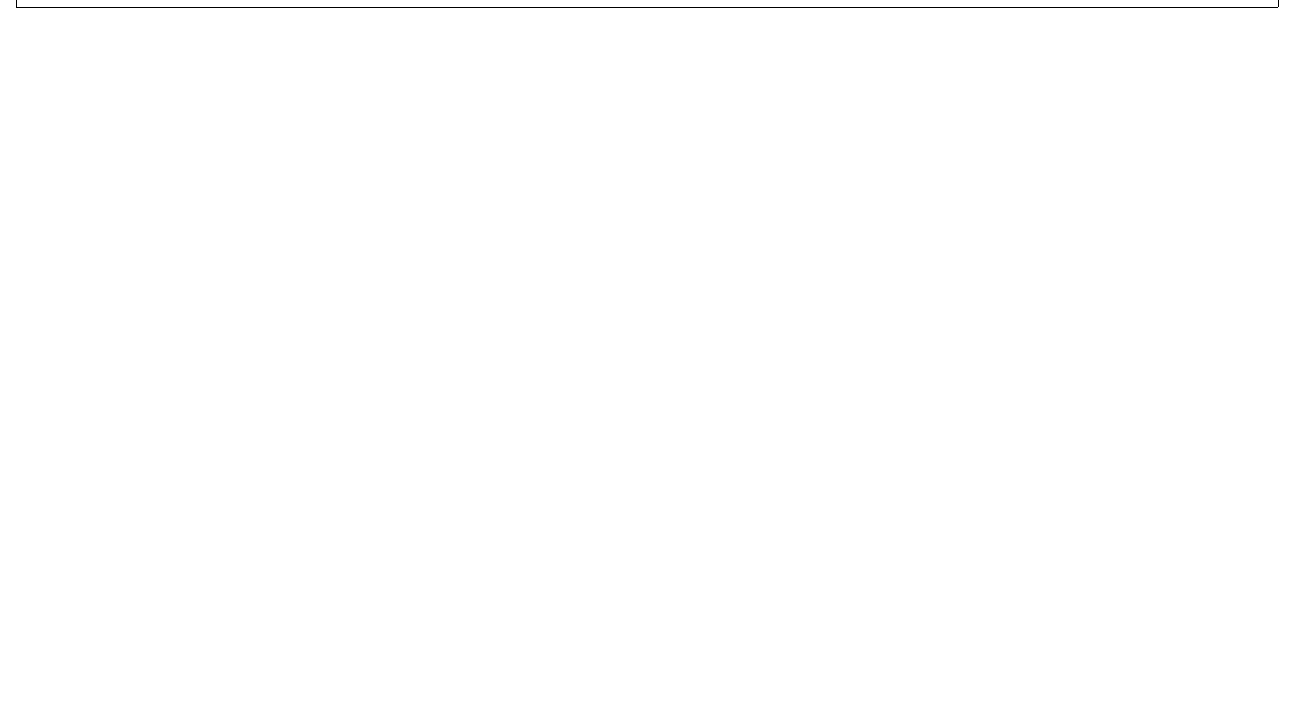
FIGUREA2 | Biplots of canonical correspondence analysis of archaeal amo A gene (A) and beta-proteobacterial 16S rRNA gen (B) from DGGE data obtained from four clayey soils over 2years. Physico-chemical data,